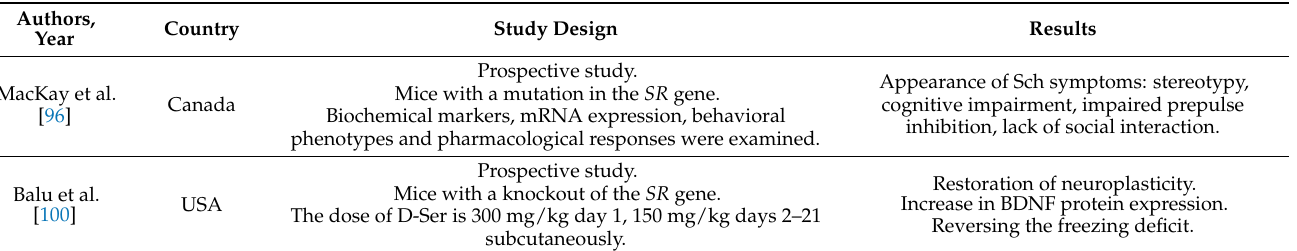
Table 3. Preclinical studies of D-serine as a new therapeutic strategy for treatment-resistant